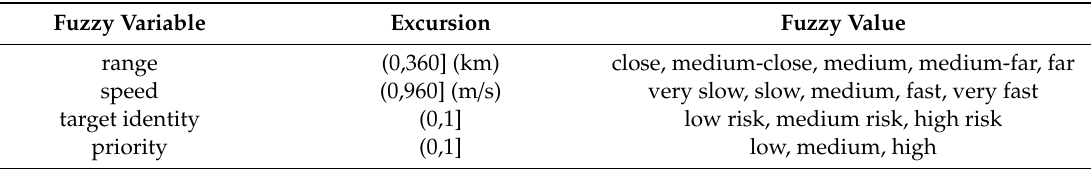
Table 1. Fuzzy values related to fuzzy